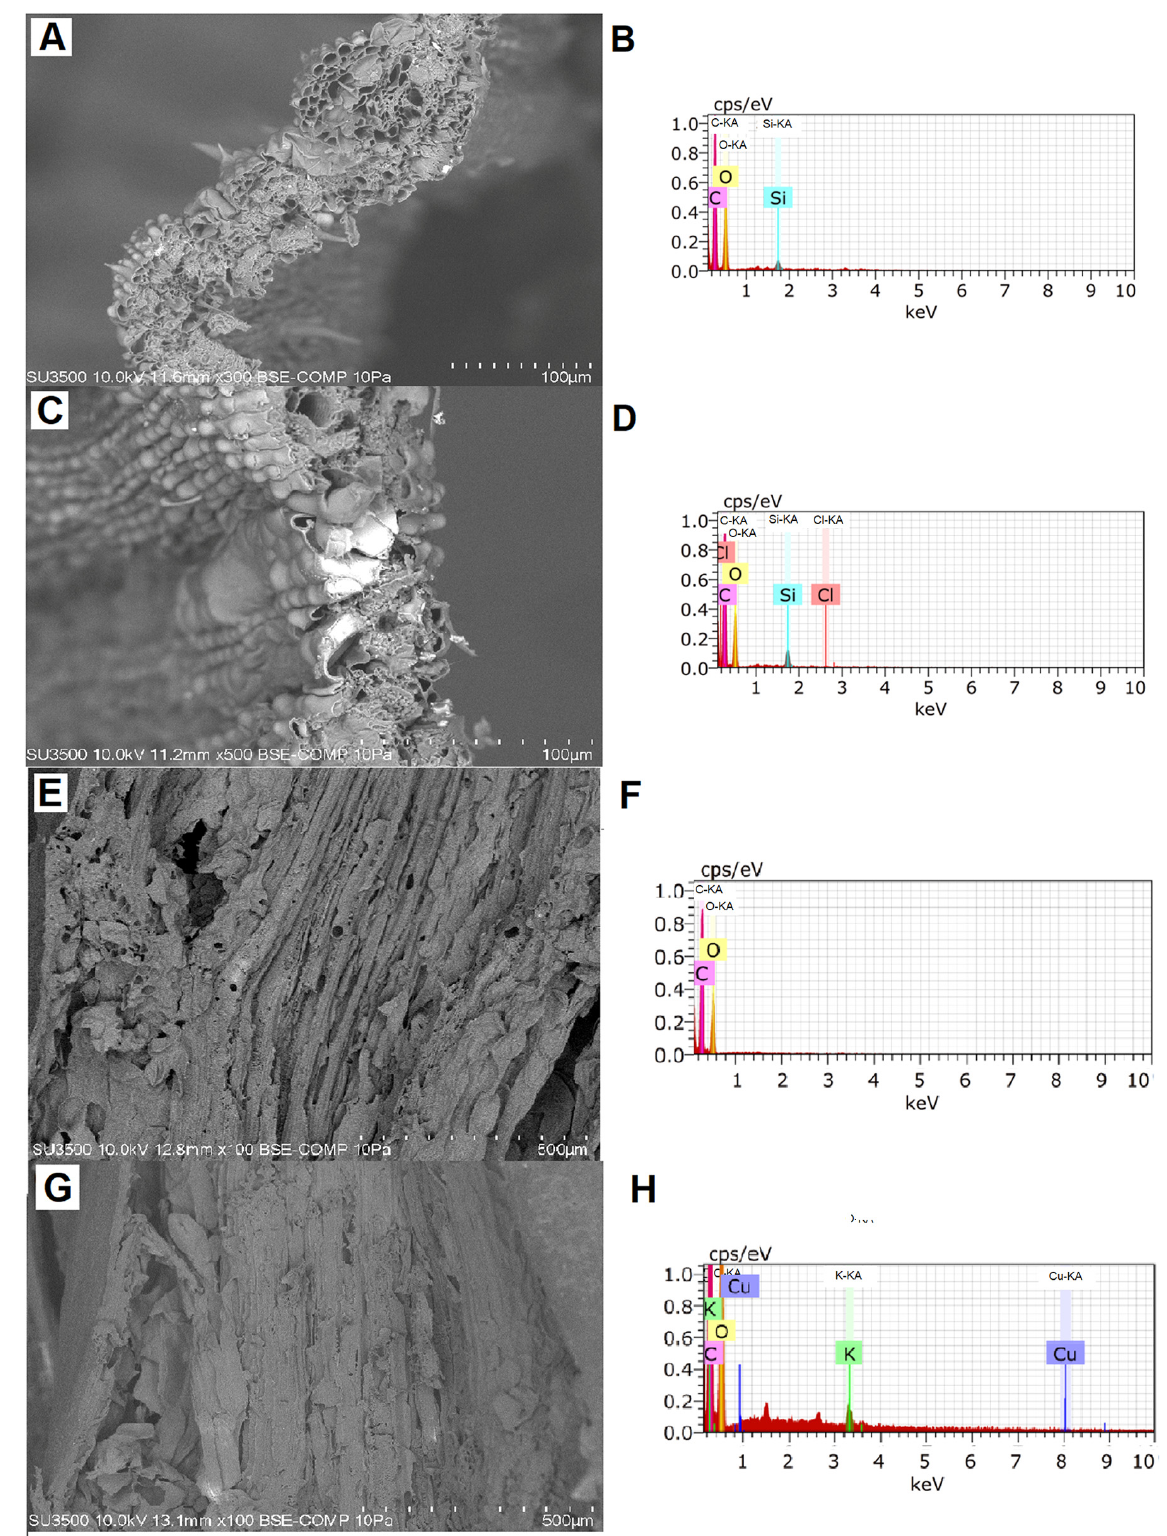
Figure 2. Scanning electron microscopy (SEM) in transversal sections of Imperata cylindrica shoot ( A ) without Cu addition, ( B ) Energy-dispersive X-ray (EDX) spectra without Cu addition, ( C ) SEM of shoot with Cu addition (300 mg kg − 1 ), and ( D ) EDX spectra with Cu addition. SEM in longitudinal sections of I. cylindrica root ( E ) without Cu addition, ( F ) EDX spectra without Cu addition, ( G ) SEM of root with Cu addition (300 mg kg − 1 ), and ( H ) EDX spectra with Cu